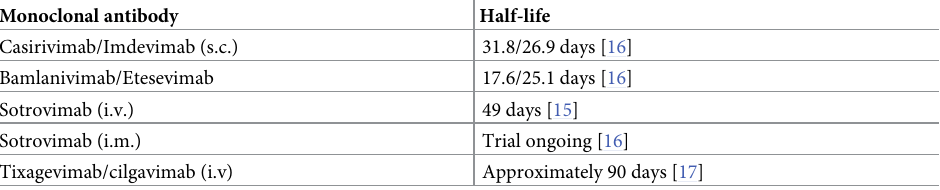
Table 1. Half-lives of the main monoclonal antibodies with neutralizing activity against SARS-CoV-2. Monoclonal antibody